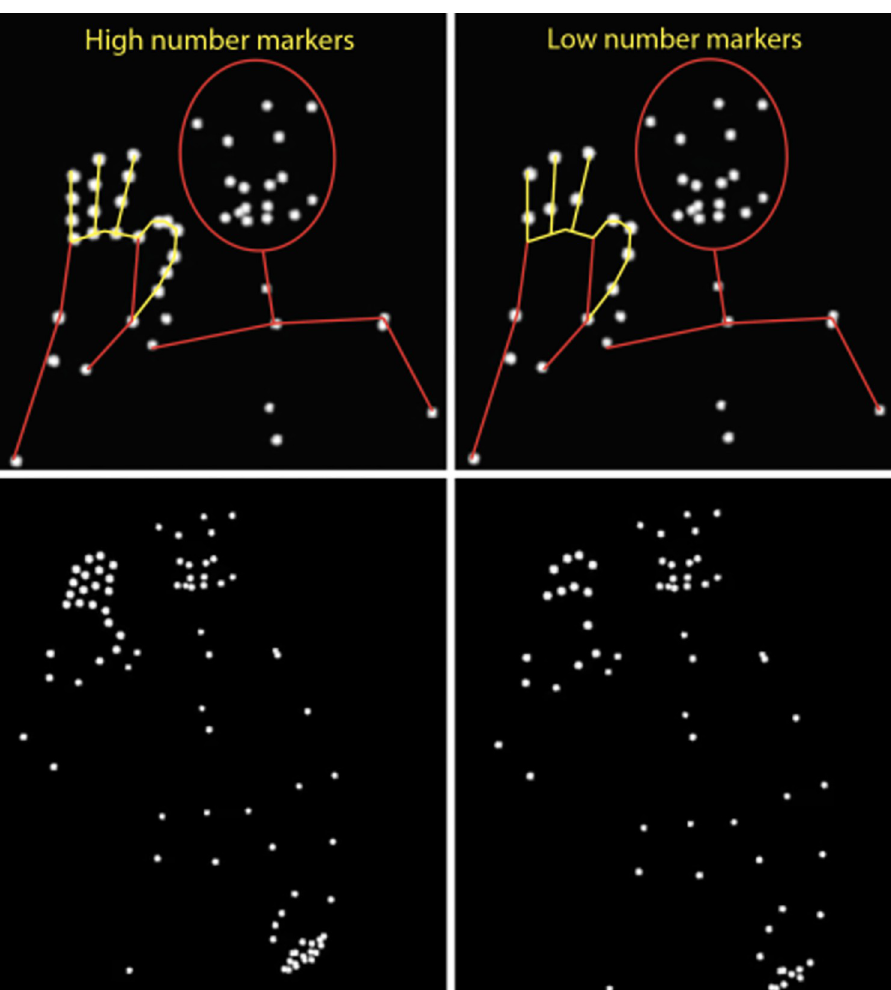
configuration of the dots. Here, the signer produces the F handshape. Bottom panel: the full view that the participants saw, including the torso, hips, and left hand. Here, the signer produces the B handshape. No connecting lines are shown, as was the case during the experiment. These marker placements were consistent across all